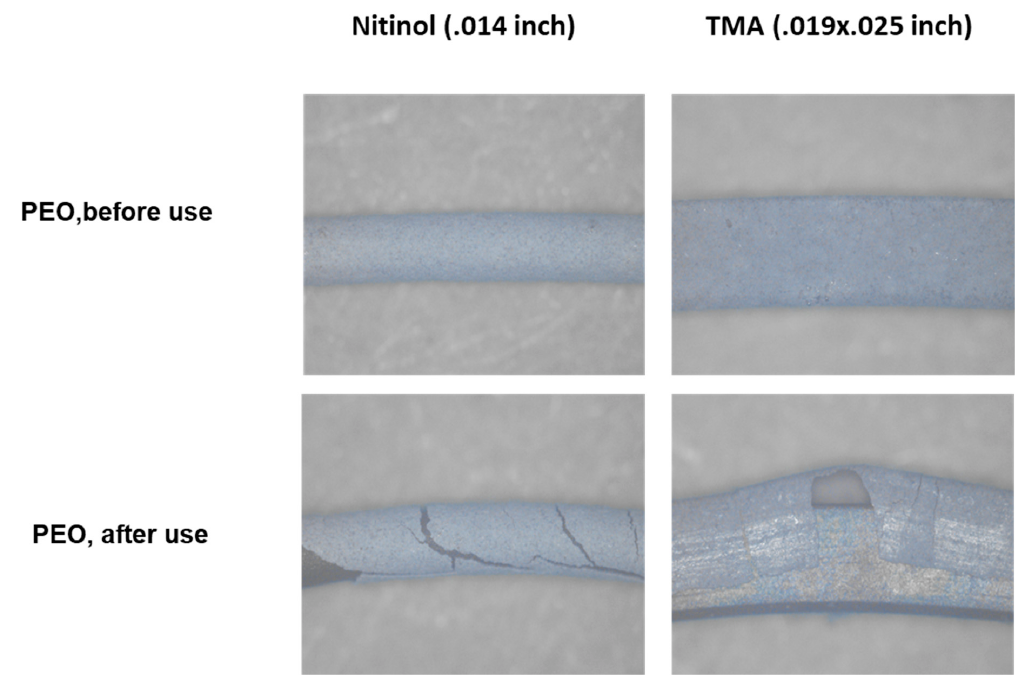
Figure 4. Stereomicroscopy of PEO-coated NiTi and β -Ti archwires. Lower panels show loss of PEO-coating after bending of the archwires.